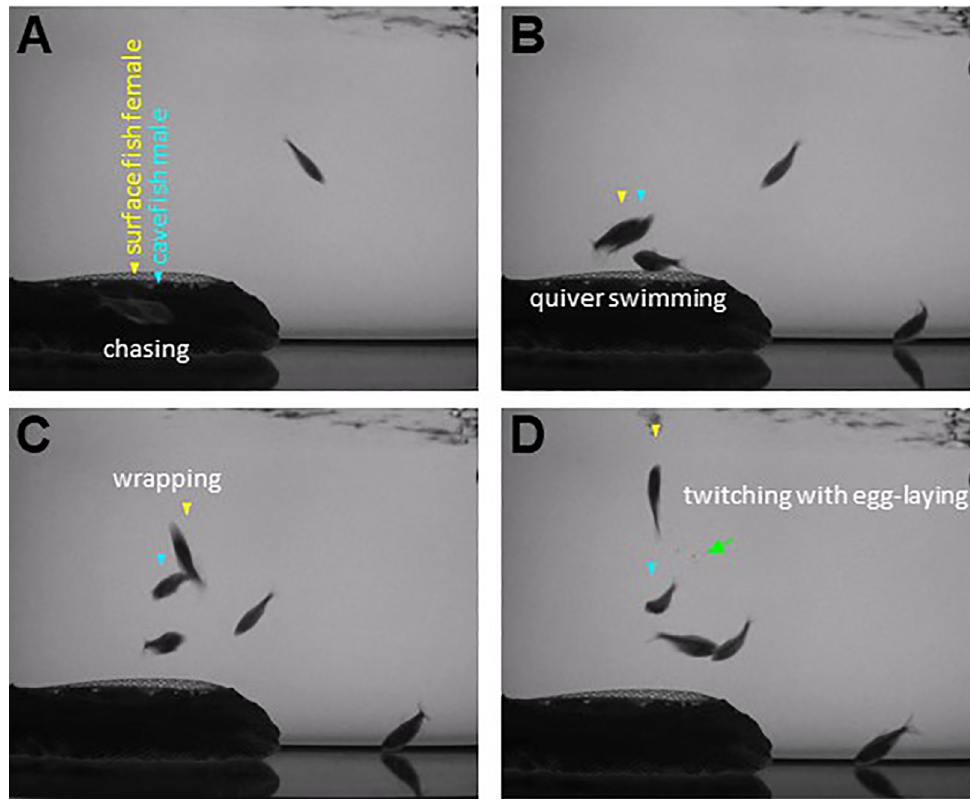
Fig 4. Cross-breeding between surface fish and cavefish. Example of a spawning event between a surface fish female (yellow arrowhead) and a cavefish male (blue arrowhead). Panels A, B, C and D show representative snapshots of the principal phases of the spawning behavior, which ends up with egg release (green arrow) in this case. Note that the other surface fish female (fish in the bottom right corner of the tank in BCD), who is not ready to spawn, does not attract any interest from the males and feeds on the eggs that have been spawned by the active